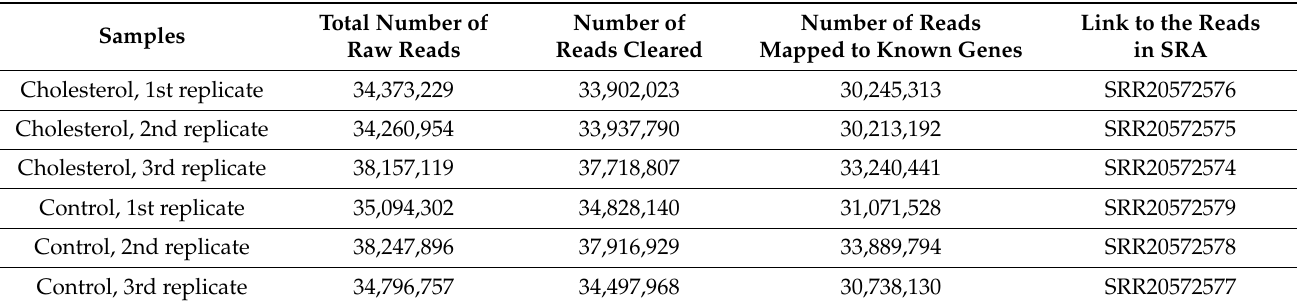
Table 1. Sequencing statistics and links to reads.